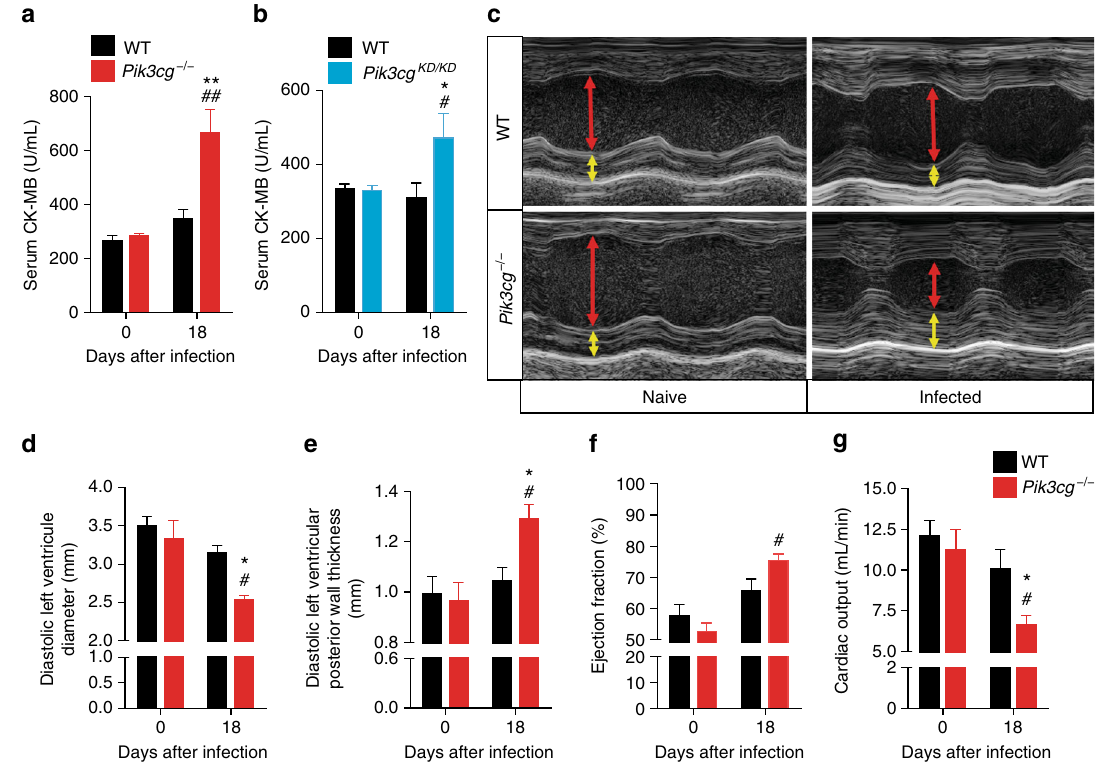
Fig. 3 PI3K γ is important for the heart function of T . cruzi -infected mice. a , b Serum CK-MB level of WT ( n = 4), Pik3cg − / − ( n = 4) ( a ) and Pik3cg KD/KD ( n = 7) ( b ) non-infected mice or 18 days post infection with 10 3 trypomastigote forms of T . cruzi Y strain. c Representative images of echocardiography in WT ( n = 6) and Pik3cg − / − ( n = 6) non-infected mice or 18 days after infection with T . cruzi . Red arrows indicate diastolic ventricular diameter and yellow arrow indicates diastolic ventricular wall thickness. d – g Diastolic left ventricle diameter ( d ), diastolic left ventricular posterior wall thickness ( e ), ejection fraction ( f ), and cardiac output ( g ) of WT ( n = 6) and Pik3cg − / − ( n = 6) non-infected mice or 18 days after infection with 10 3 trypomastigote forms of T . cruzi Y strain. * P < 0.05 and ** P < 0.01 relative to WT-infected mice and # P < 0.05 and ## P < 0.01 relative to non-infected group (one-way ANOVA with Tukey ’ s post hoc test in a , b , d – g ). Data are representative of two independent experiments (mean ± s.e.m in a , b , d – g